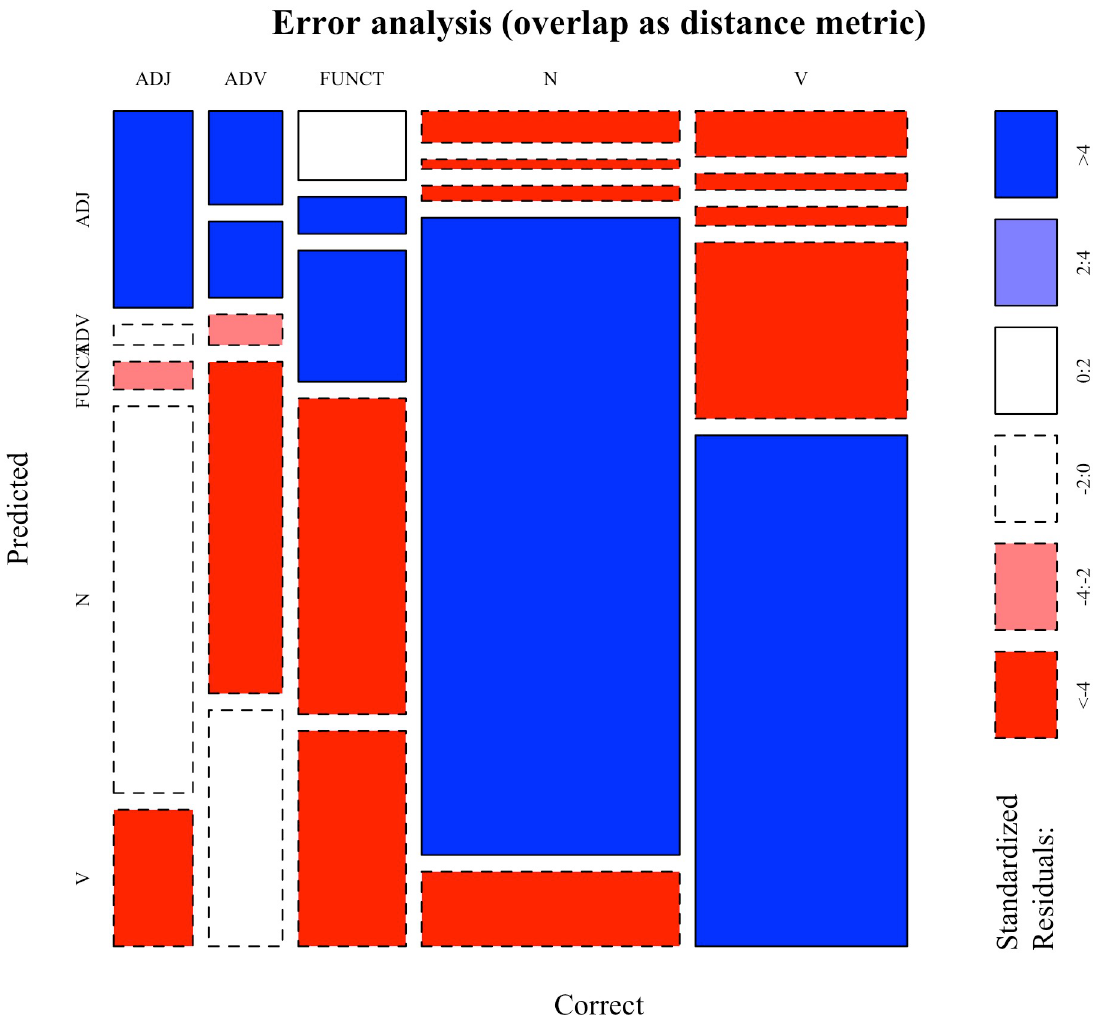
Fig 7. Numeric overlap-based classification—Error analysis. Mosaic plot showing the error analysis of the categorization experiment performed using numeric overlap as the distance metric to retrieve nearest neighbors. Blue cells indicate cases in which the observed frequencies significantly exceed the expected frequencies under the assumption of independence between Correct and Predicted PoS tags, while red mark the opposite scenario. ADJ: adjectives; ADV: adverbs; FUNCT: function words; N: nouns; V: verbs. For a detailed explanation of how to interpret the plot, refer to the main